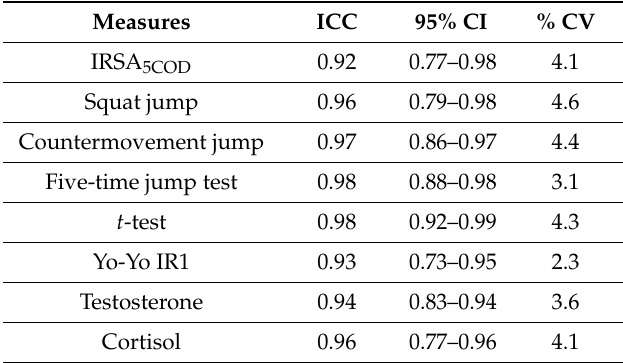
Table 1. Intraclass correlation coe ffi cients (ICCs) for relative reliability and coe ffi cients of variation for absolute reliability of the applied physical fitness